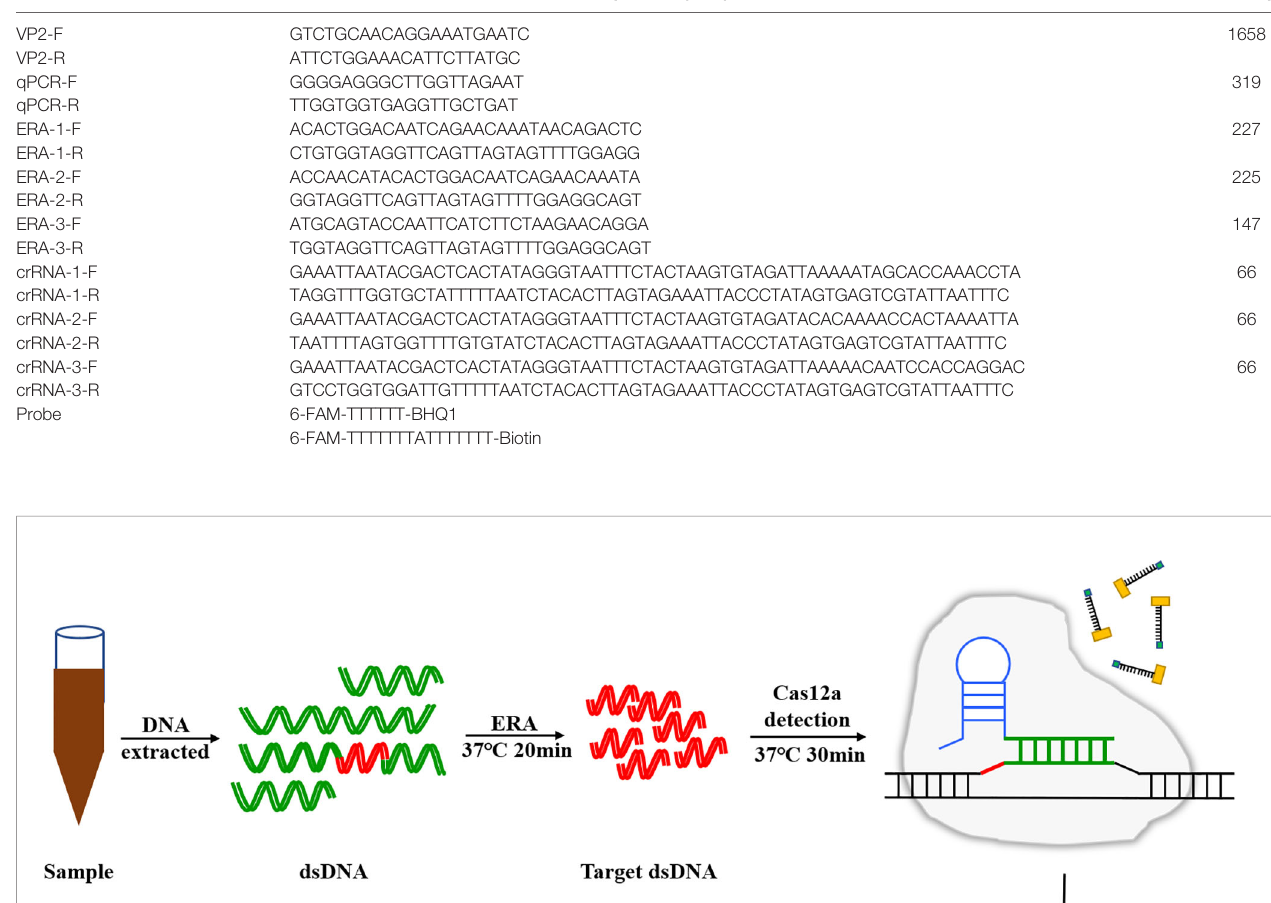
TABLE 1 | Sequences of the primers and LFD probe used in this work.